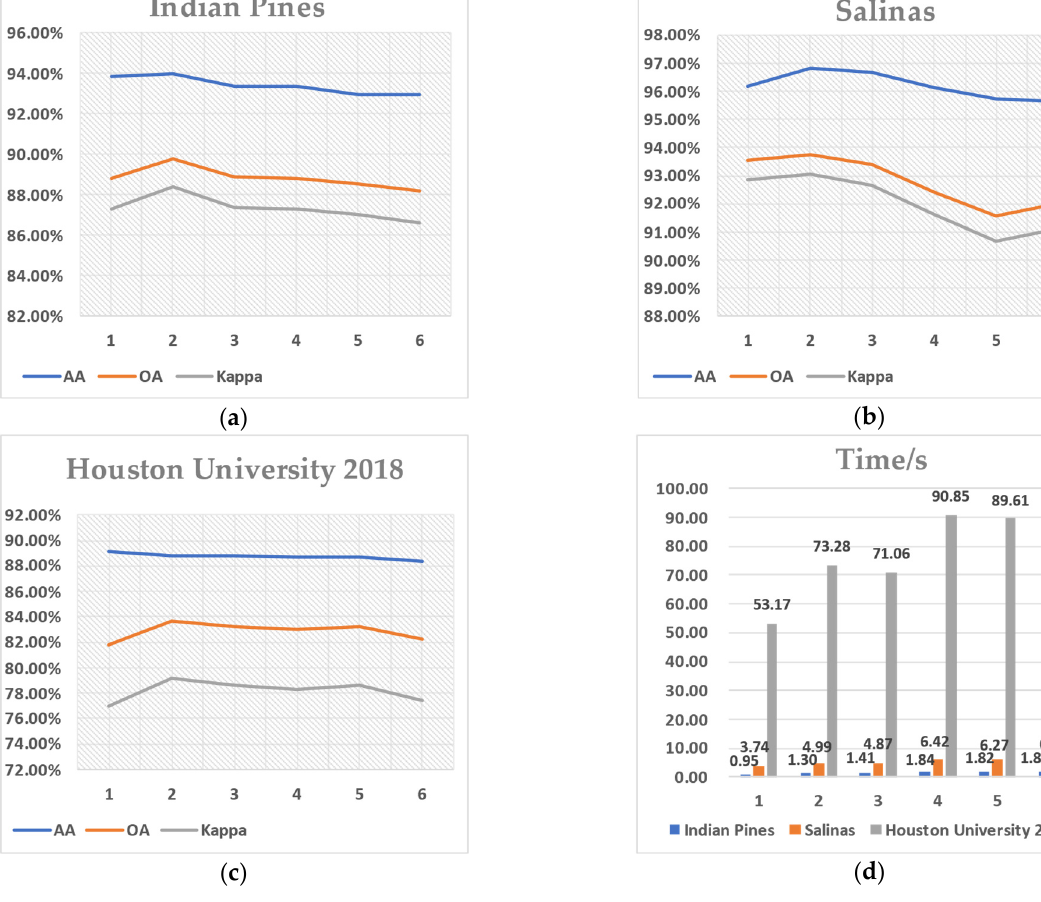
Figure 6. Effect of using different 𝜎 in three datasets. ( a ) Indian Pines, ( b ) Salinas, ( c ) Houston University 2018, and ( d ) computing time in corresponding datasets.